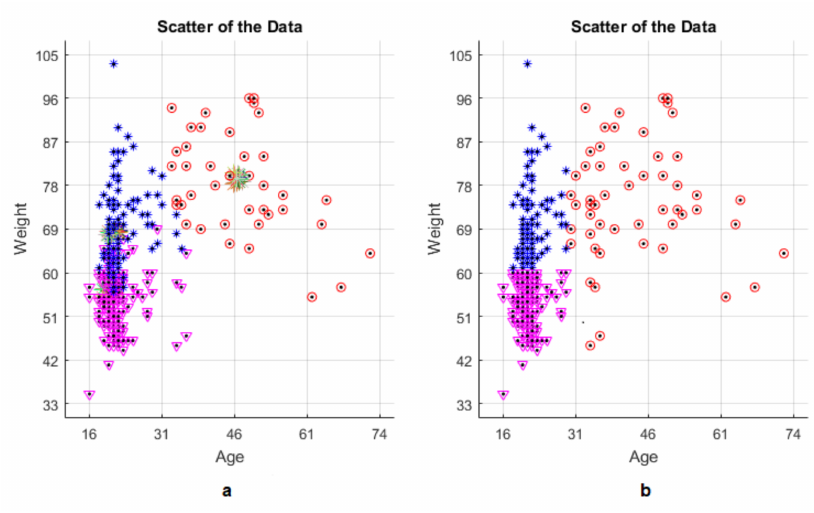
Figure 7. ( a ) Comparison of the computed results and ( b ) the real values for LTIR.